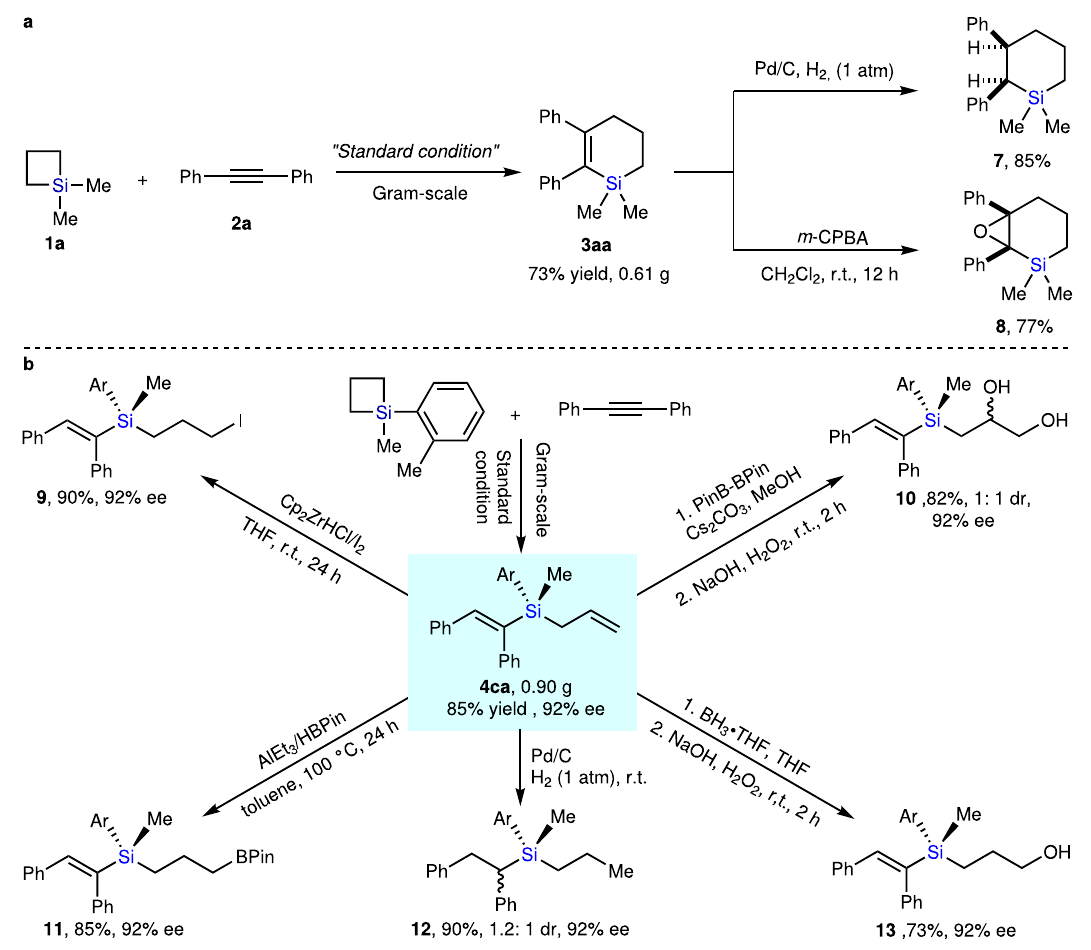
Fig. 3 Scale up experiments and synthetic utility of our products. a Gram-scale synthesis and synthetic utility of 3aa . b Gram-scale synthesis and synthetic utility of enantioenriched silicon-stereogenic vinylsilanes 4ca . The details of the experiments have been provided in Supplementary Information